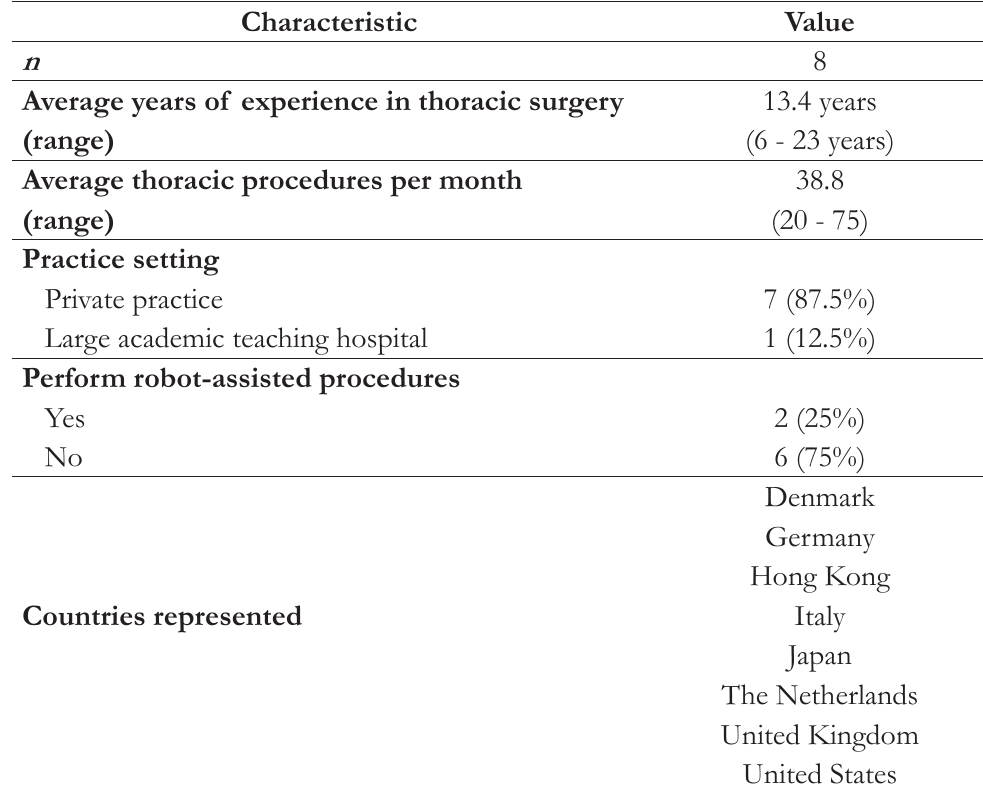
Table 1. Advisor